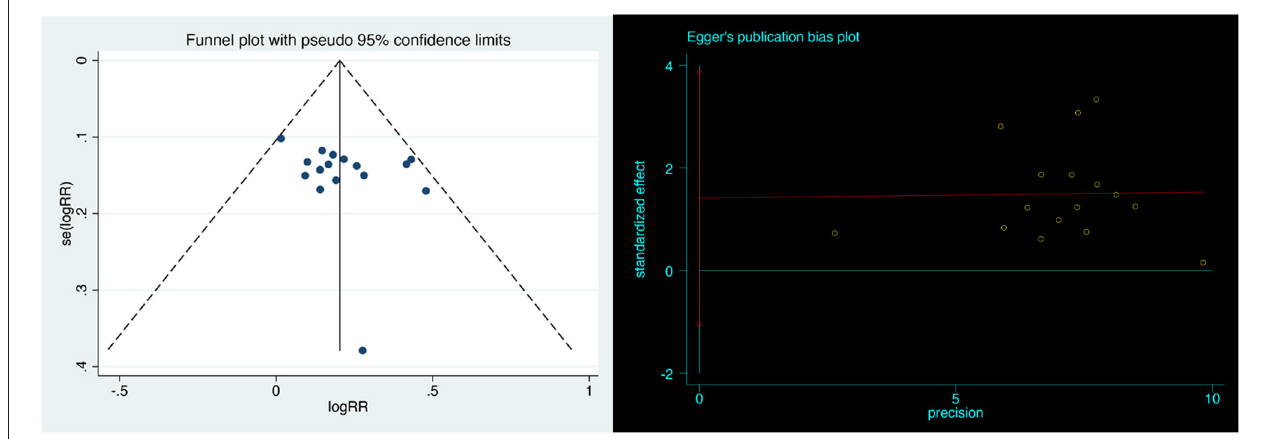
FIGURE 8 | Publication bias for vortioxetine in all included